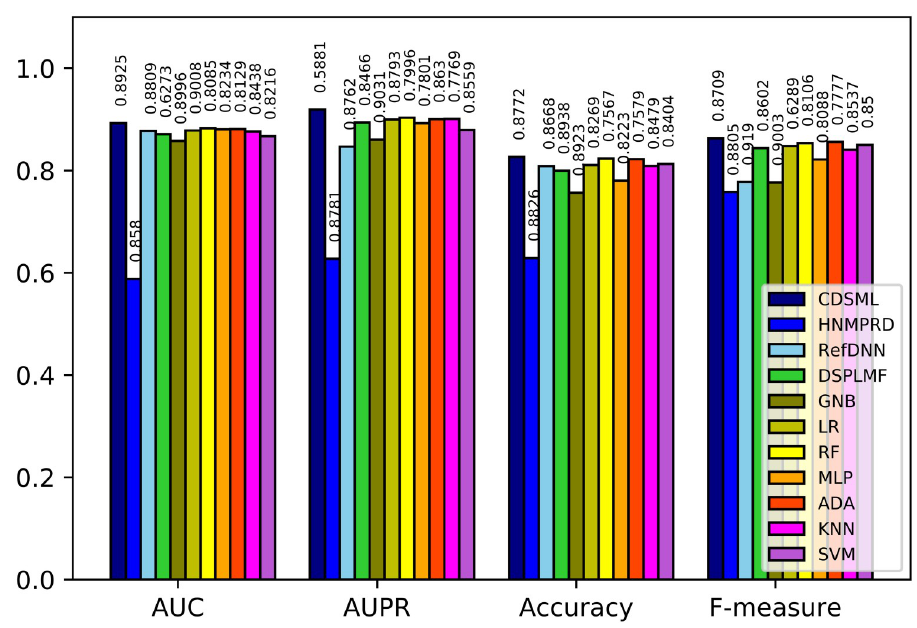
Fig 10. The performance of methods in on leukemia tissue.